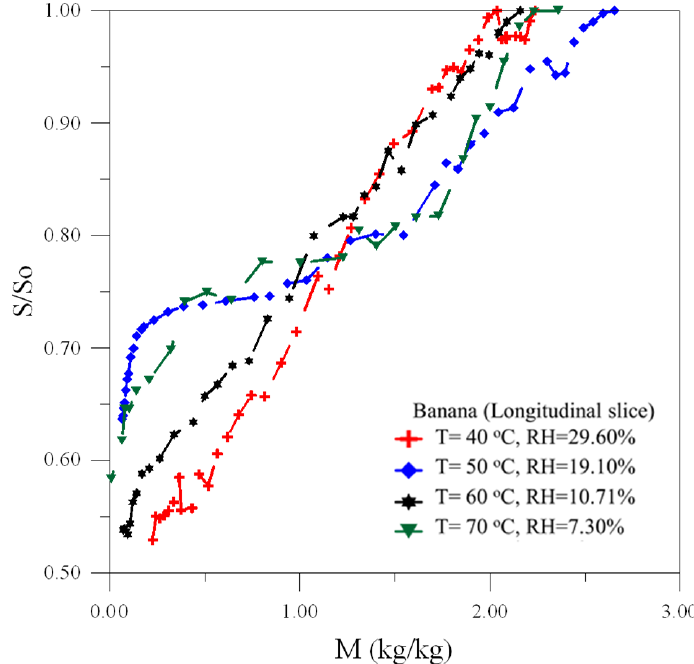
Figure 6. Dimensionless surface area of longitudinal sliced banana as a function of moisture content.